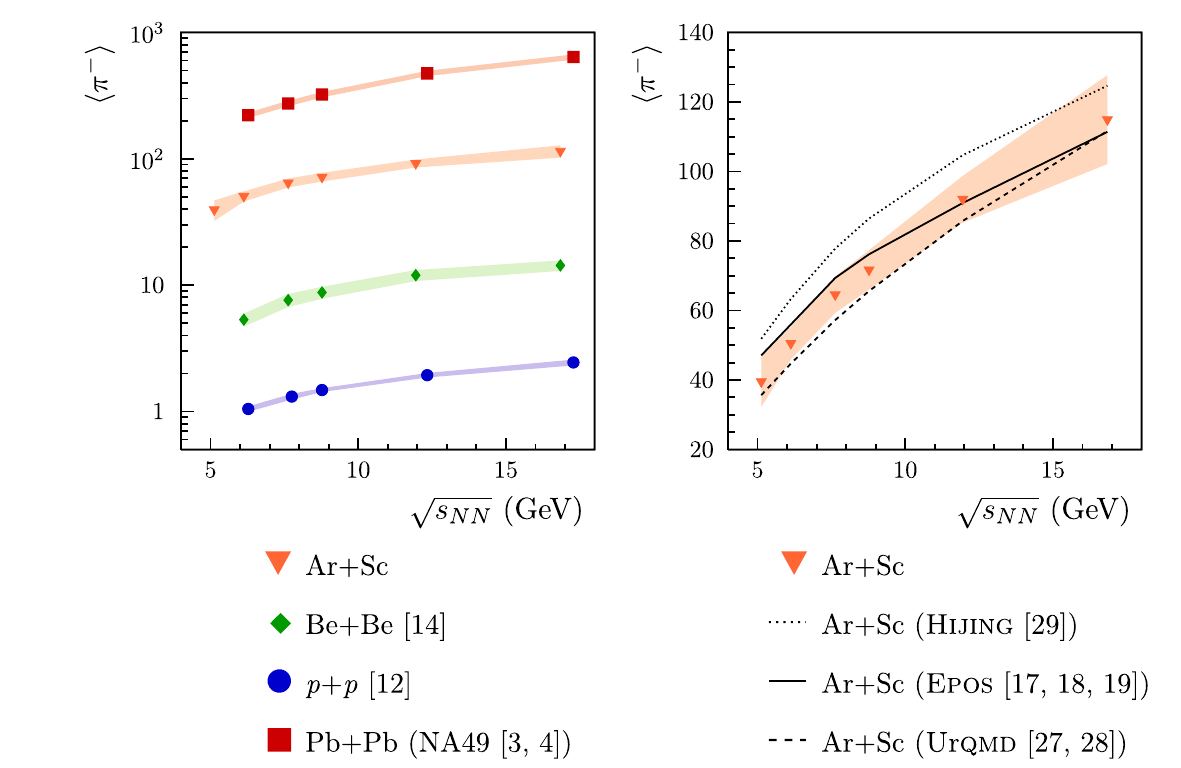
Fig. 21 Left: The mean multiplicity of negatively charged pions in inelastic p + p interactions and in central Ar+Sc, Be+Be and central Pb+Pb collisions as a function of center of mass collision energy. Statis- ticaluncertaintiesofthedatapointsaresmallerthanthemarkersize.The Fig. 22 Ratio of the mean pion multiplicity (cid:5) π (cid:6) over the mean number of wounded nucleons (cid:5) W (cid:6) plotted versus the collision system size for beam momenta from 19 A to 150 A GeV / c . The data points for different beam momenta were shifted for better readability. Statistical uncertainties are marked with vertical bars and are smaller than marker size. Systematic uncertainties are marked with shaded